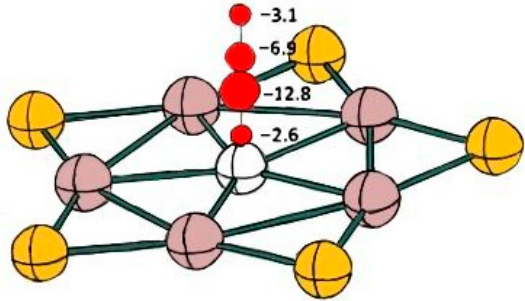
Figure 5. NICS value analysis of D 5h BAl 5 S 5+ .